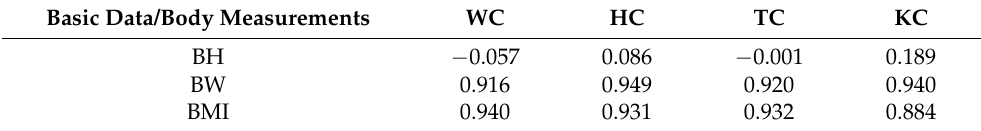
Table 6. Pearson correlation coefficients between participants’ basic data and their body measurements.